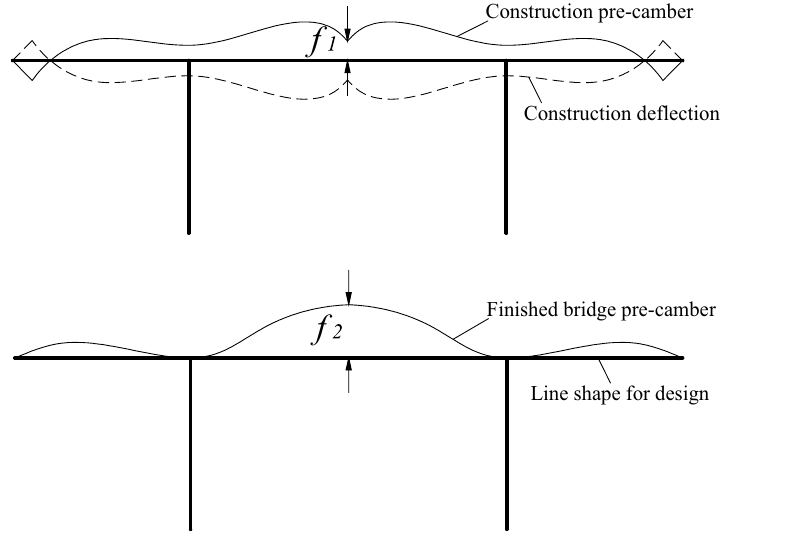
Figure 1. Pre-camber of continuous rigid frame